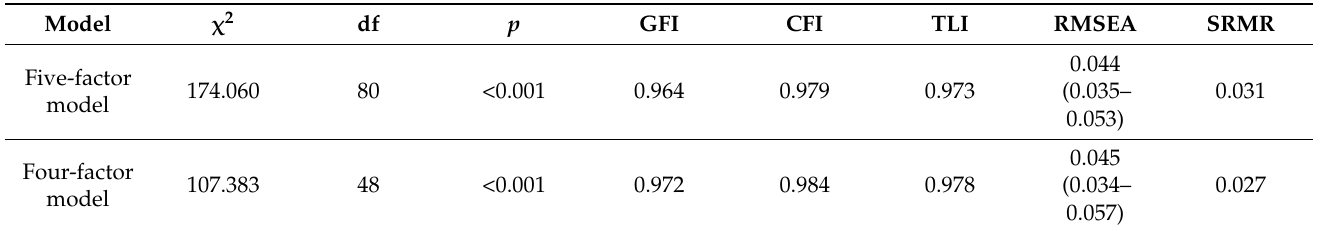
Table 2. Confirmatory factor analysis models fit indices ( n = 604).